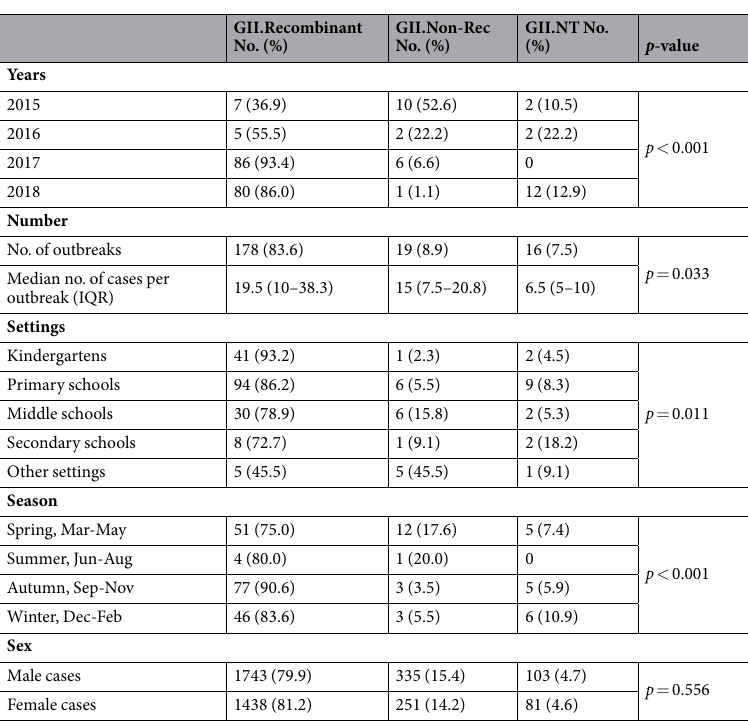
GII.Recombinant No. (%)